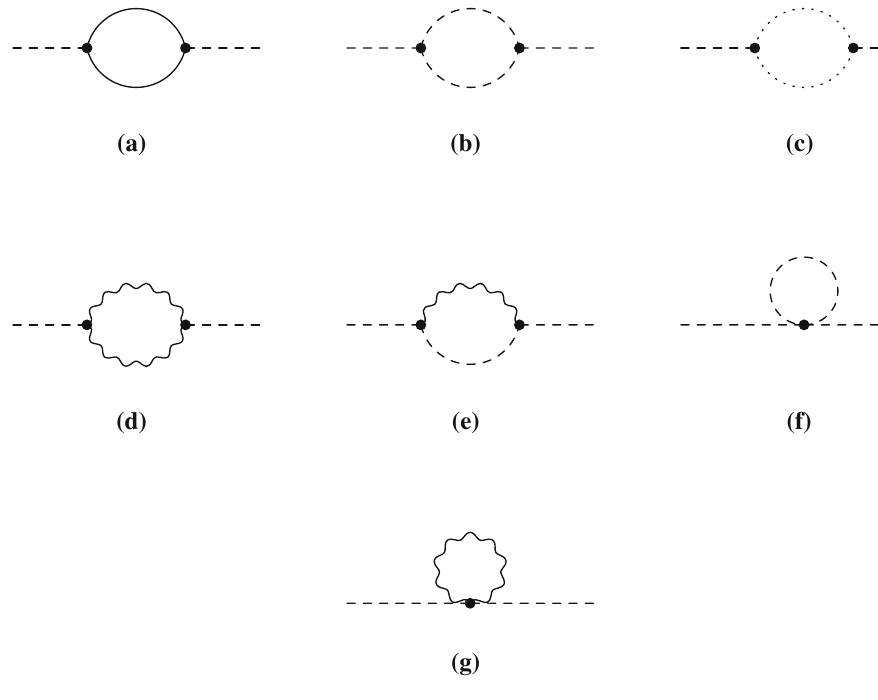
Fig. 13 Generic one-loop diagrams for the scalar self-energy